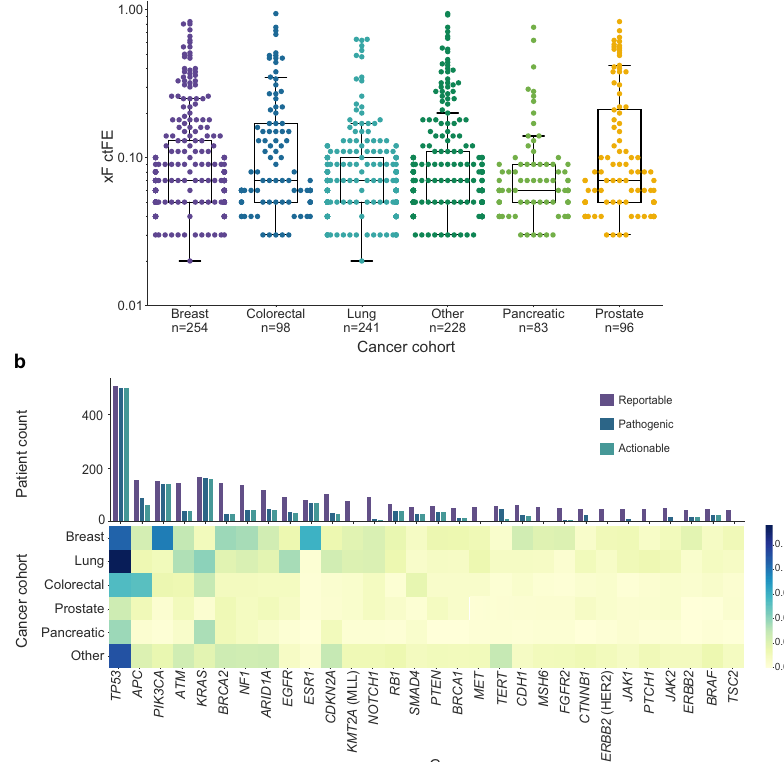
Fig. 3 Circulating tumor fraction estimate (ctFE) and mutational landscape by cancer type. a Median ctFE among the most common cancer types was 0.07, with the exception of prostate (ctFE = 0.06). b The mutational landscape was evaluated in the xF 1000 cohort, with variants categorized as reportable, pathogenic, or actionable. Across all patients, the most commonly mutated gene was TP53 . The heatmap was normalized within rows to depict the most prevalent variants detected for each common cancer type in the cohort (breast n = 254, colorectal n = 98, lung n = 241, prostate n = 96, and pancreatic n =